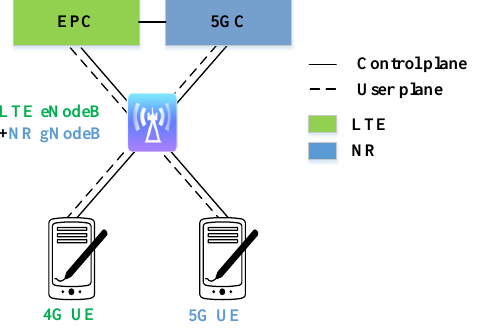
Figure 1. DSS architecture.